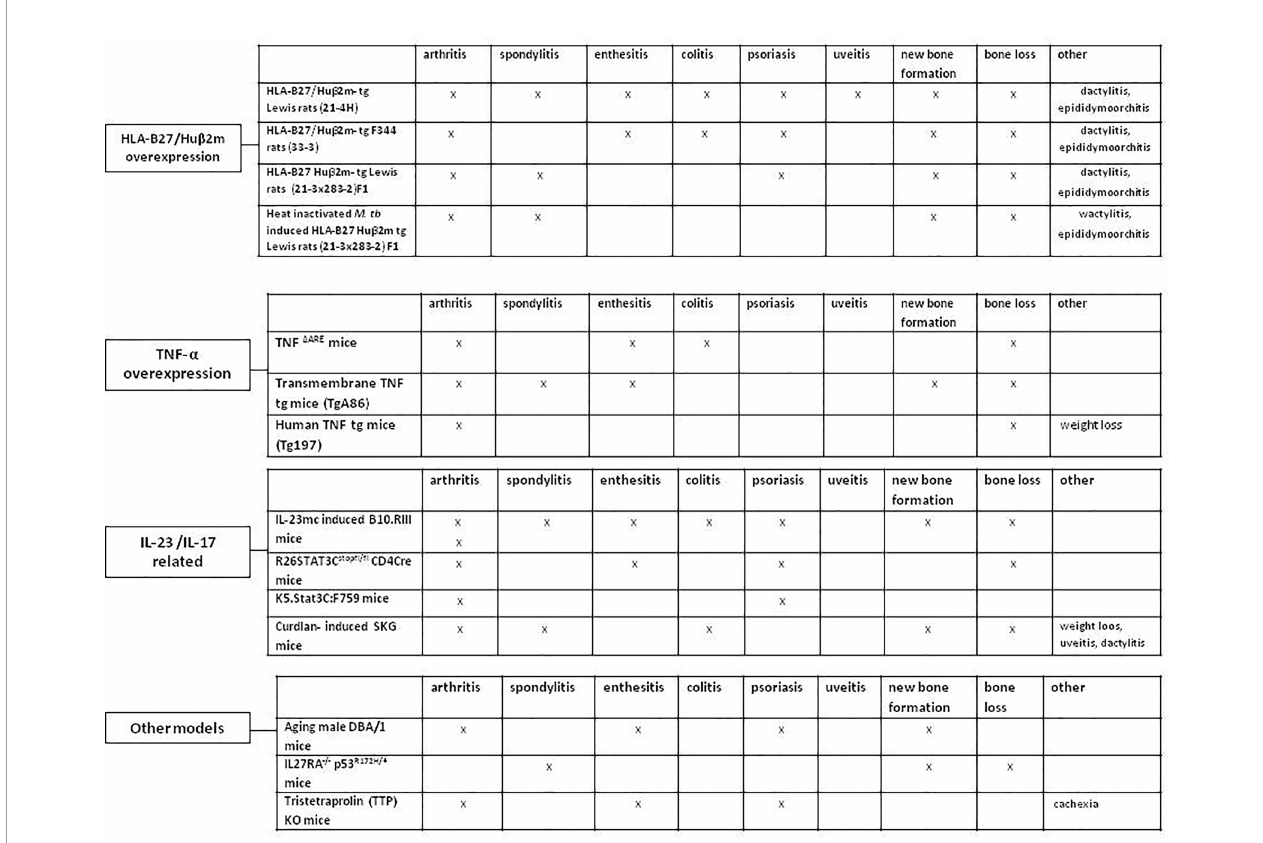
FIGURE 2 | Animal models resembling human spondyloarthritis. HLA-B27/Hu b 2m- tg, HLA-B27/human b 2 microglobulin transgenic rat; TNF- a , Tumor necrosis factor alpha; IL-23, Interleukin-23; IL-17, Interleukin-17; M. tub, Mycobacterium tuberculosis; IL-23mc, Interleukin-23 minicircle; Human TNF tg mice, Human tumor necrosis factor transgenic